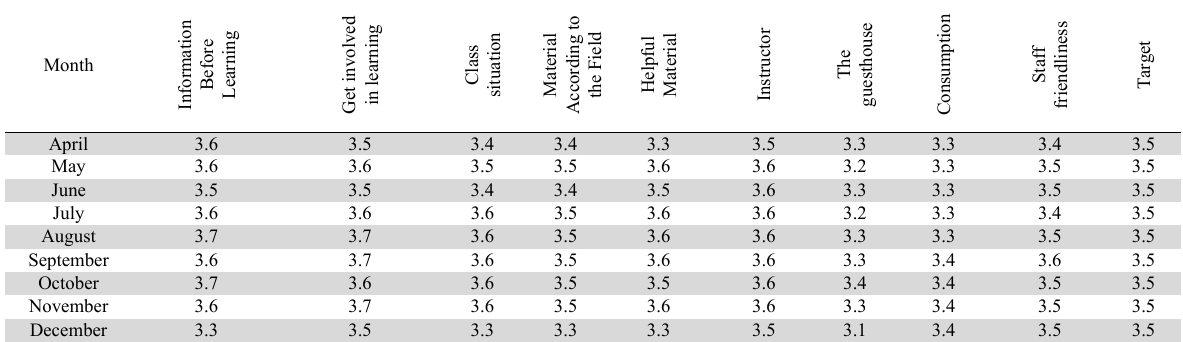
Recapitulation of service